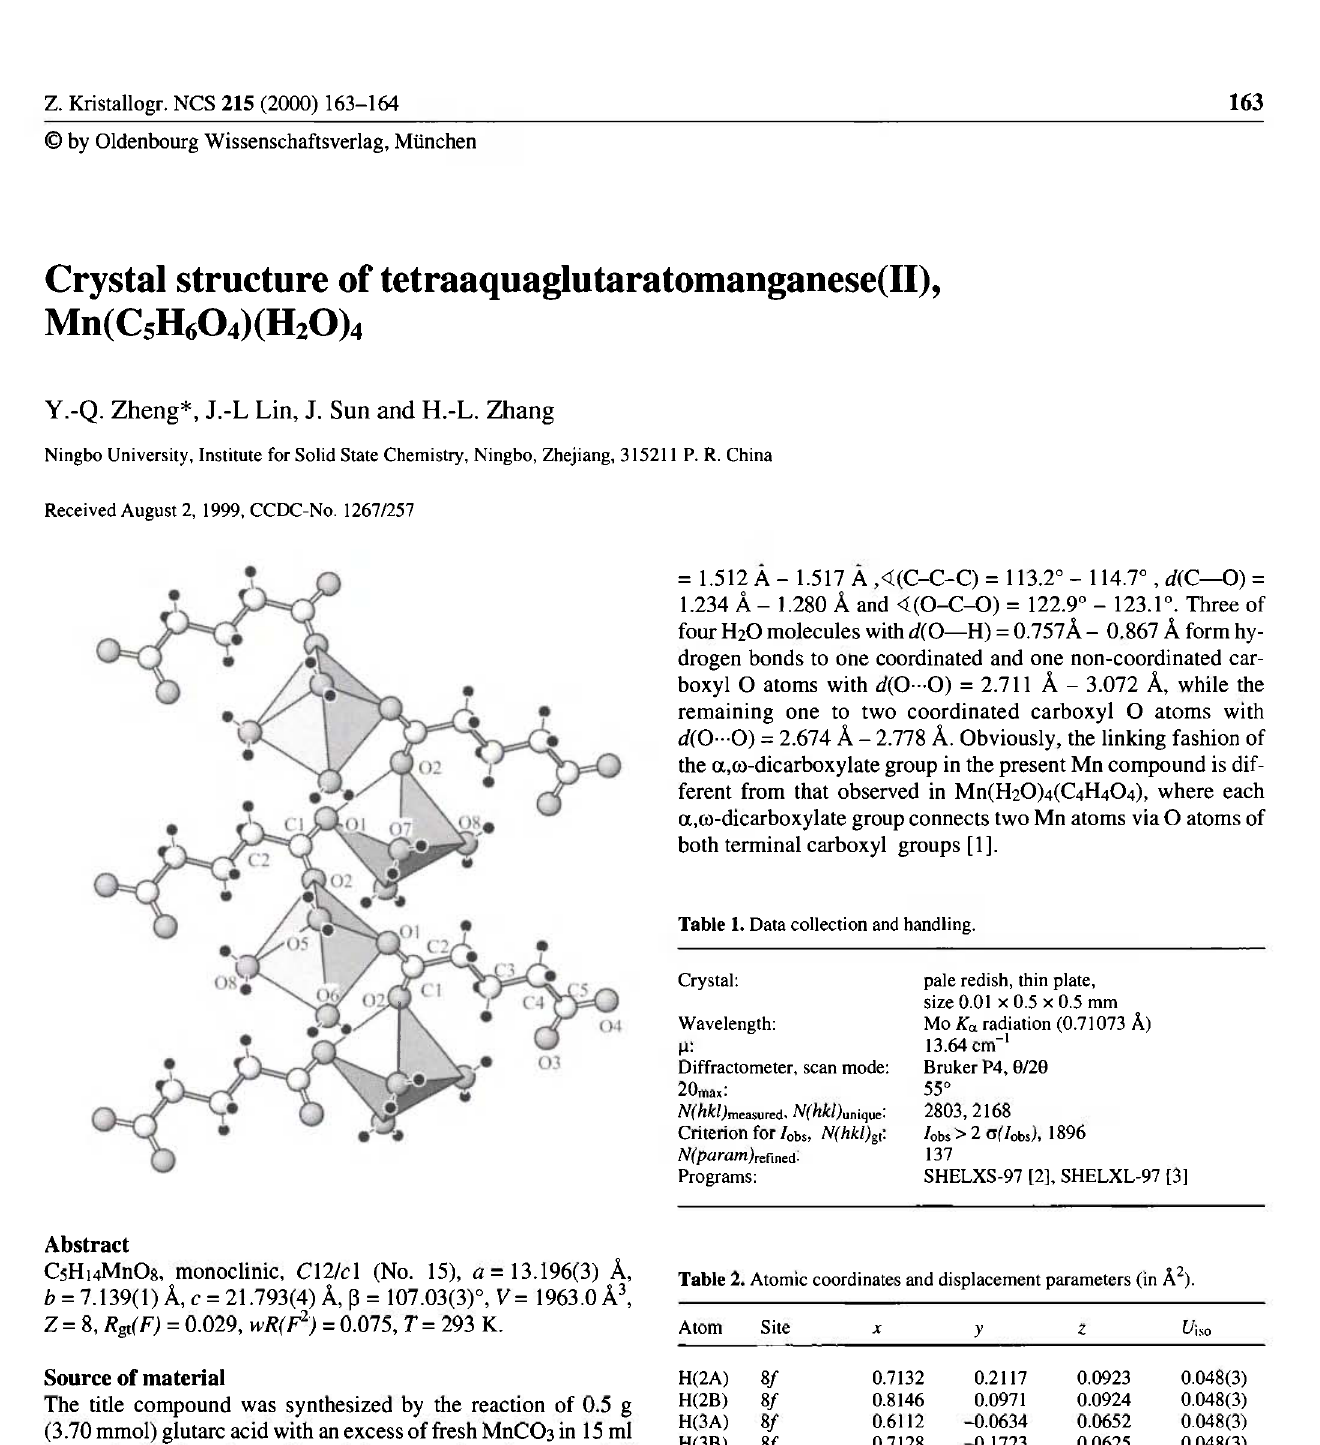
Table 2. Atomic coordinates and displacement parameters (in Ä 2